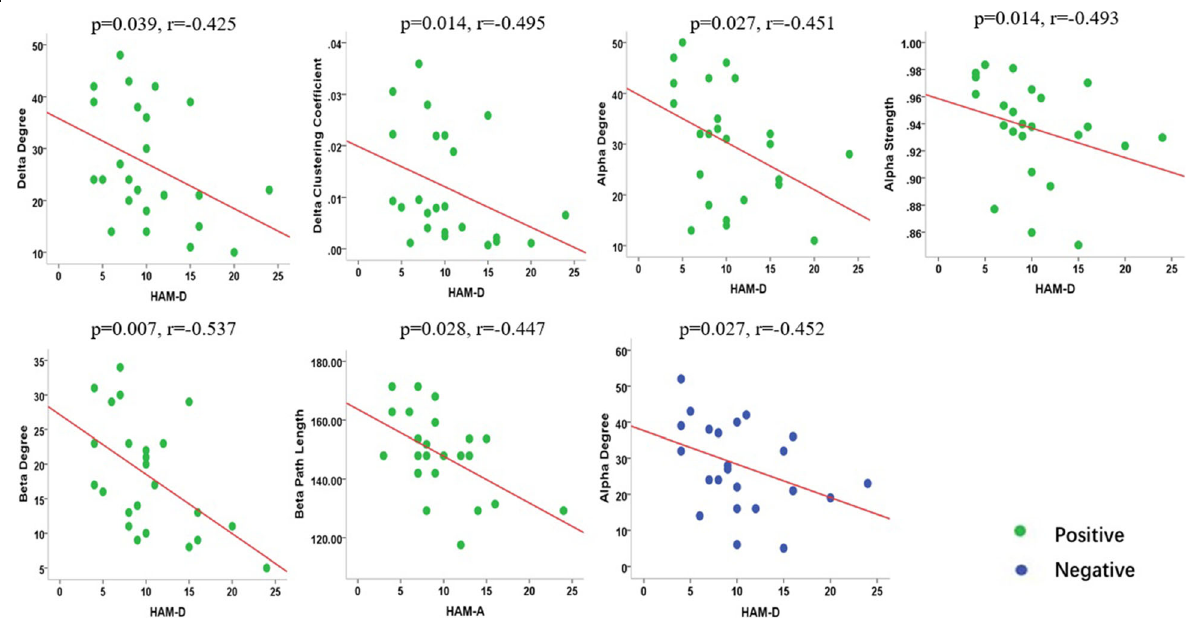
Fig. 7 Correlation between the parameters of graph theory and neuropsychological scales in the migraine patients in viewing the positive emotional stimuli (green point) and negative emotional stimuli (blue point). In positive emotional stimuli, the HAM-D showed a negative correlation with D and C in the delta frequencies, a negative correlation with D and S in the alpha frequency as well as D in the beta frequency. HAM-A showed a negative correlation with L in the beta frequency. In negative emotional stimuli, the HAM-D score of migraine patients showed a negative correlation with D in the alpha